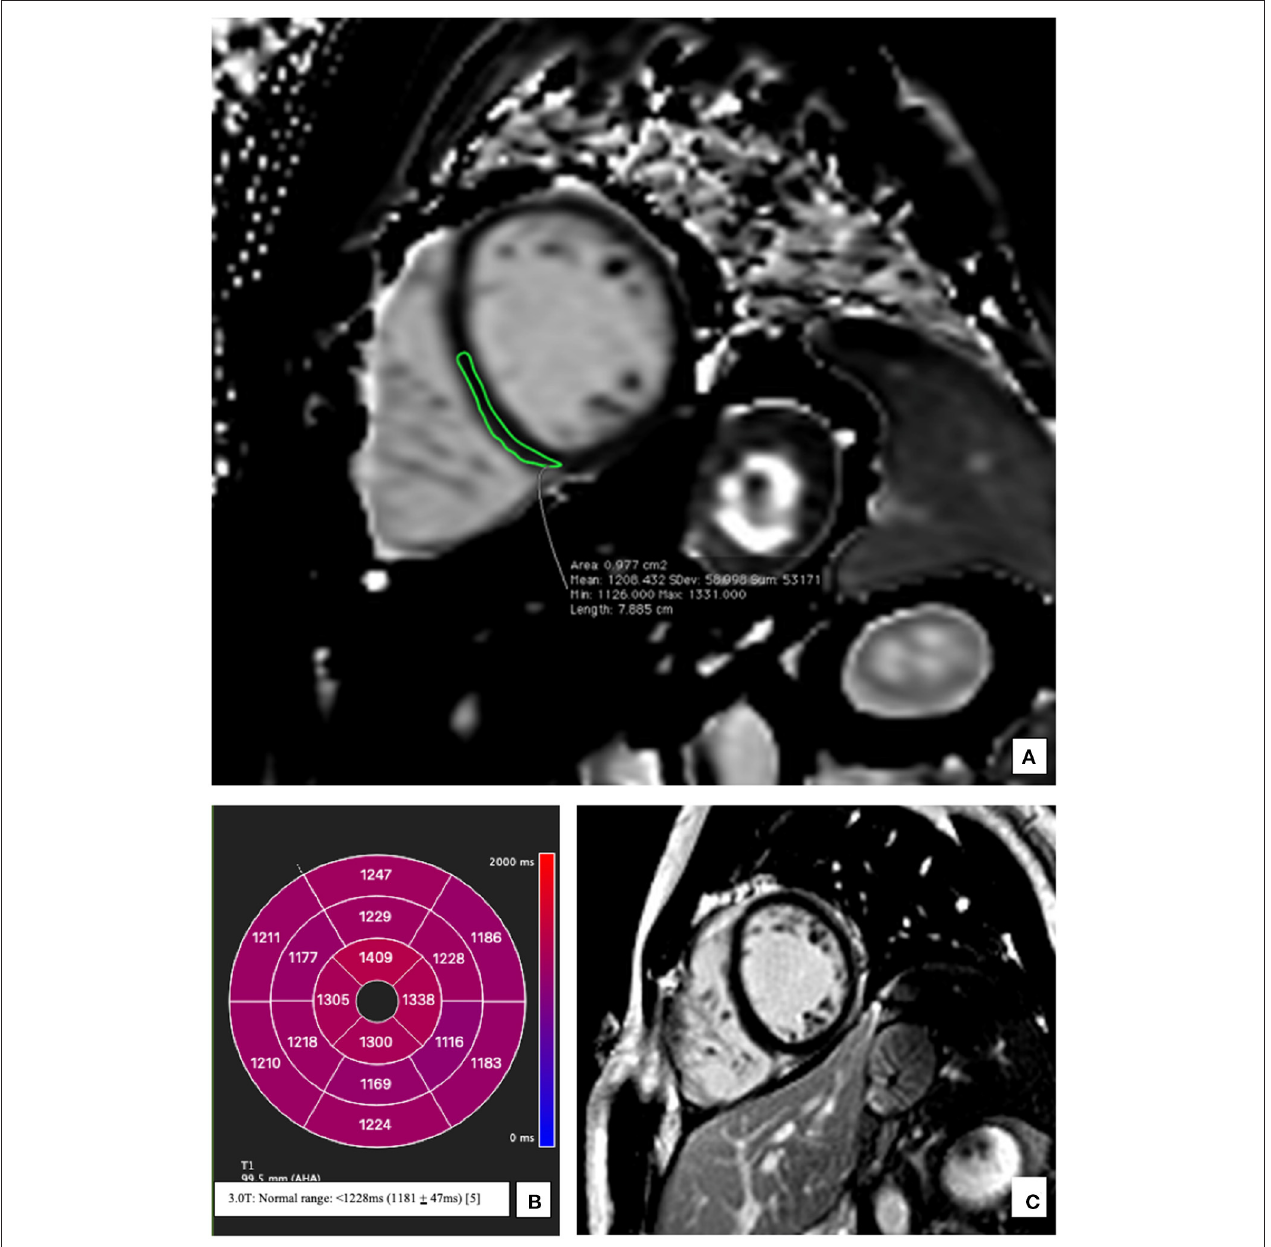
FIGURE 3 | Representative native T1 mapping image and the corresponding late gadolinium enhancement (LGE) image at follow up after 3 months. (A) Midventricular short axis image (SAX) of T1 map showing normal T1 times at follow up; an example from the inferoseptal segment (demarcated green area: 1,208ms) (B) Bullseye plot showing the native T1-times. Segmentation was performed according to the AHA 16-segment model. Native T1 times show a return to baseline at follow-up except for values in apical myocardium which correspond to the residual scar tissue reflecting chronic myocarditis (C) Corresponding mid-ventricular SAX LGE image still without evidence of